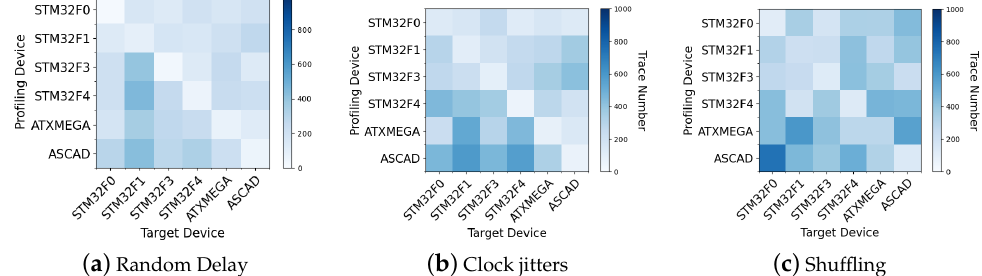
Figure 5. Guessing entropy: denoising different types of noises with our U-Net-based